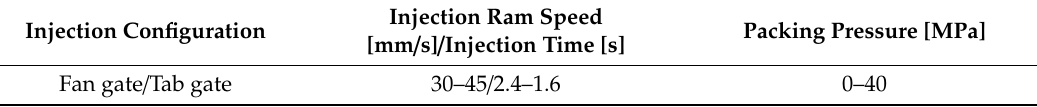
Table 1. Injection conditions used for fiber orientation characterization in the